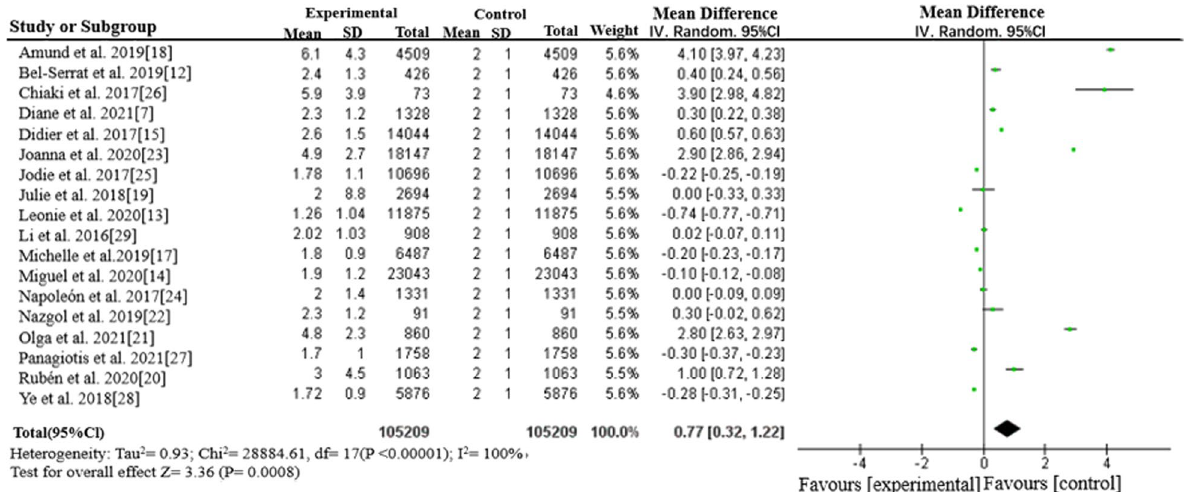
Fig. 3 Forest plot for screen time of 6–14 year old school children (continuous